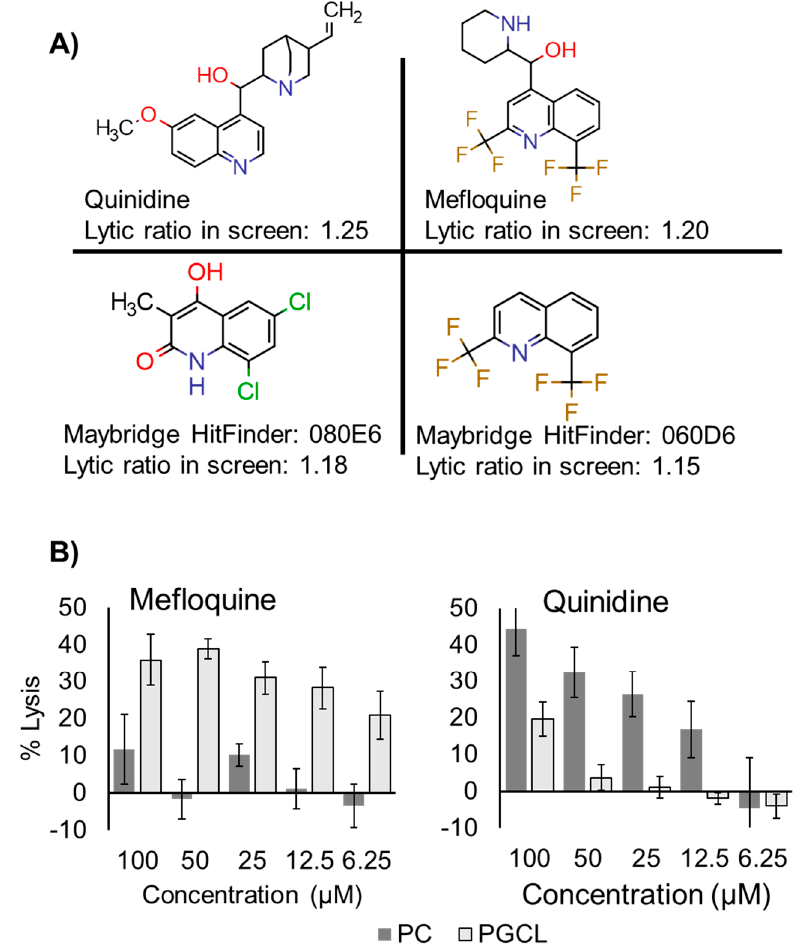
Figure 3. Quinoline-containing compounds identified in the screen. ( A ) Structures, identifiers, and lytic ratios of quinidine containing screen hits. ( B ) Dose response for mefloquine (left) and quinidine (right) for liposome lysis against PGCL and PC liposomes. Mefloquine showed dose-dependent, PGCL-specific lytic activity.